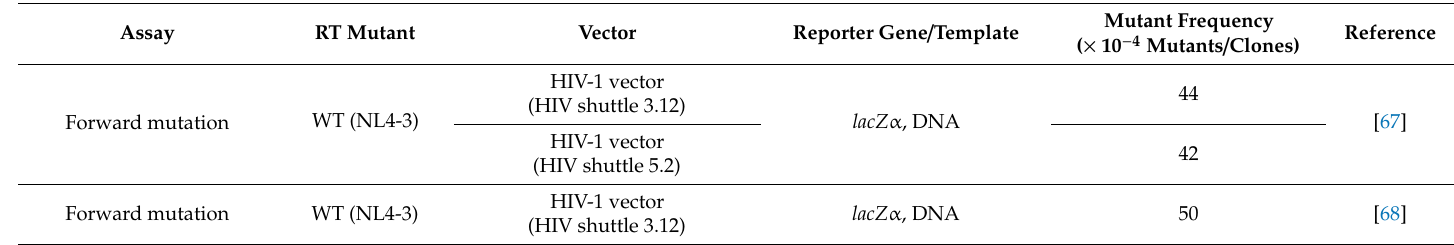
Table 4. Mutant frequencies of HIV-1 RT measured in cell-based fidelity